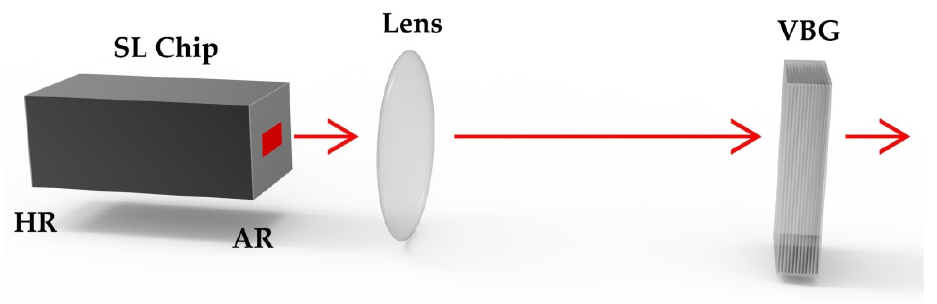
Figure 4. Structure of VBG-ECSL.